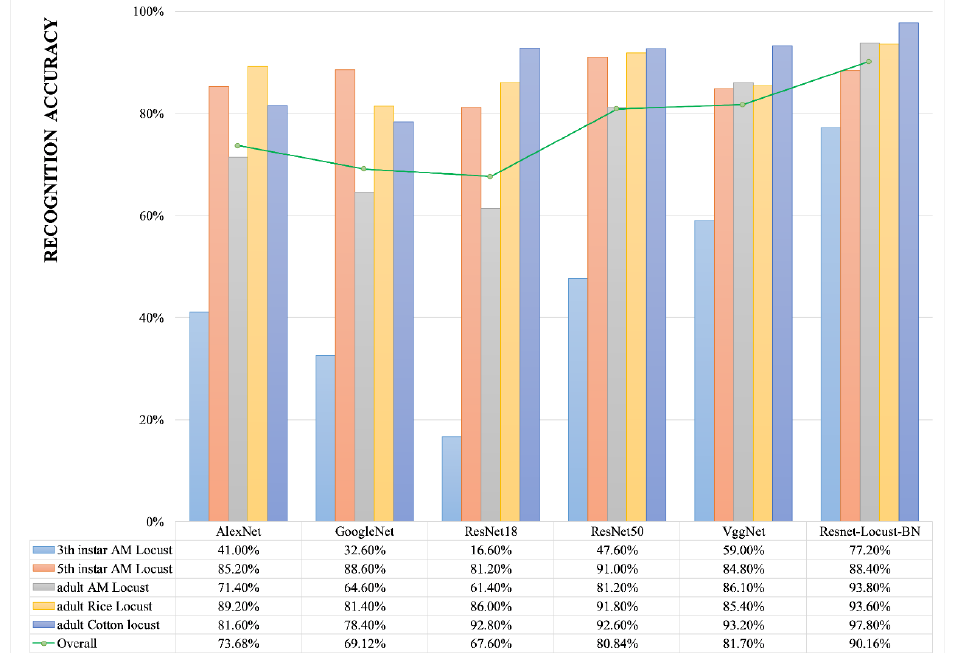
Figure 8. Accuracy comparison of the six CNN locust identification models.